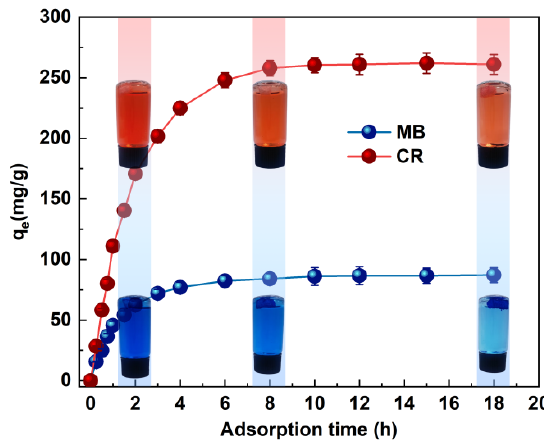
Figure 4. Effects of the adsorption time on the MB and CR adsorption capacity (pH value pH = 7, ambient temperature T = 20 °C).